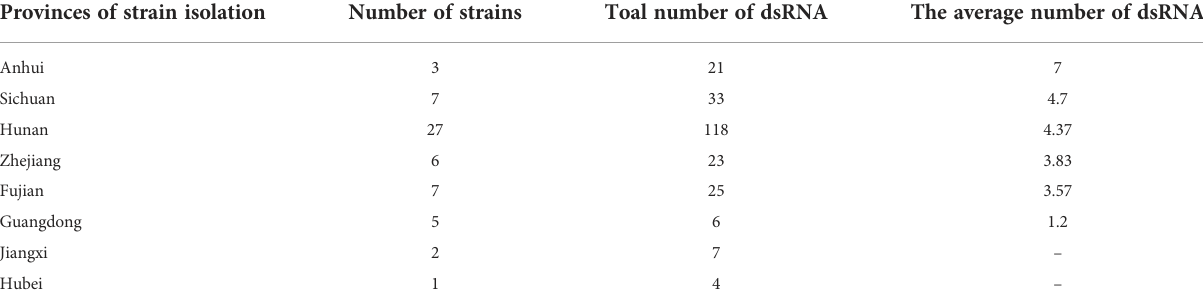
TABLE 1 Table of dsRNA bands in P. vexans . Provinces of strain